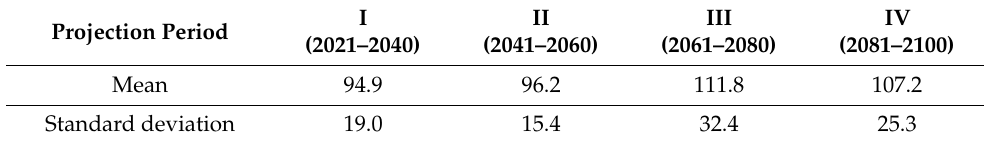
Table 6. Future runoff statistics in the Hanseok SHP plant basin [Unit: m 3